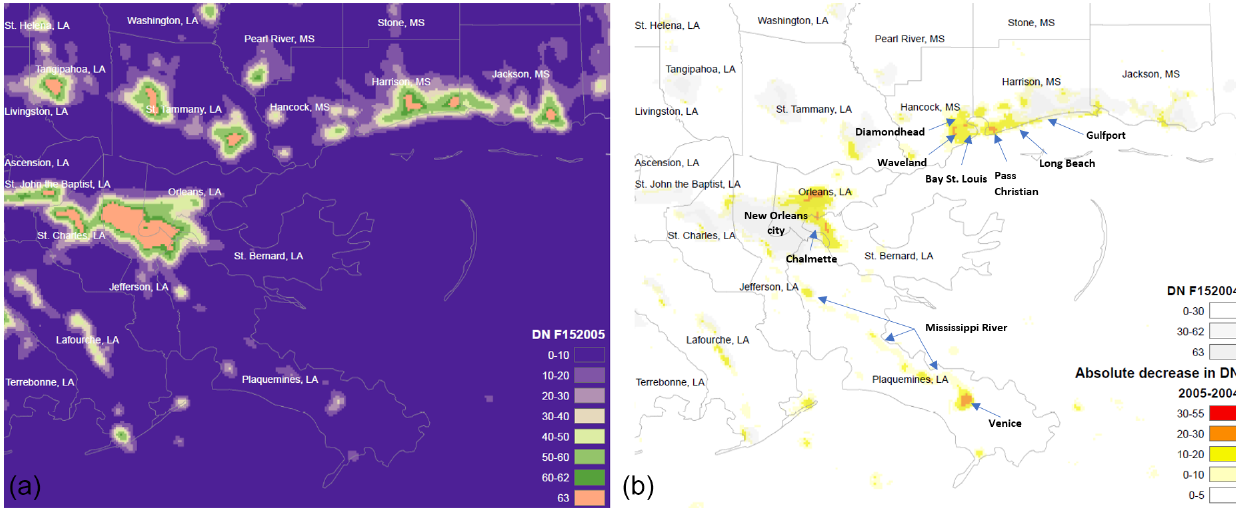
Figure 5. Absolute change in night light intensity from 2004 to 2005. Based on own calculations using satellite F15, corrected with the Elvidge et al. (2014) calibration method. (a) Night light intensity in the study region, year of Katrina 2005. Top-coded pixels are indicated in orange. (b) Absolute difference of pixel value (DN) between 2004 and